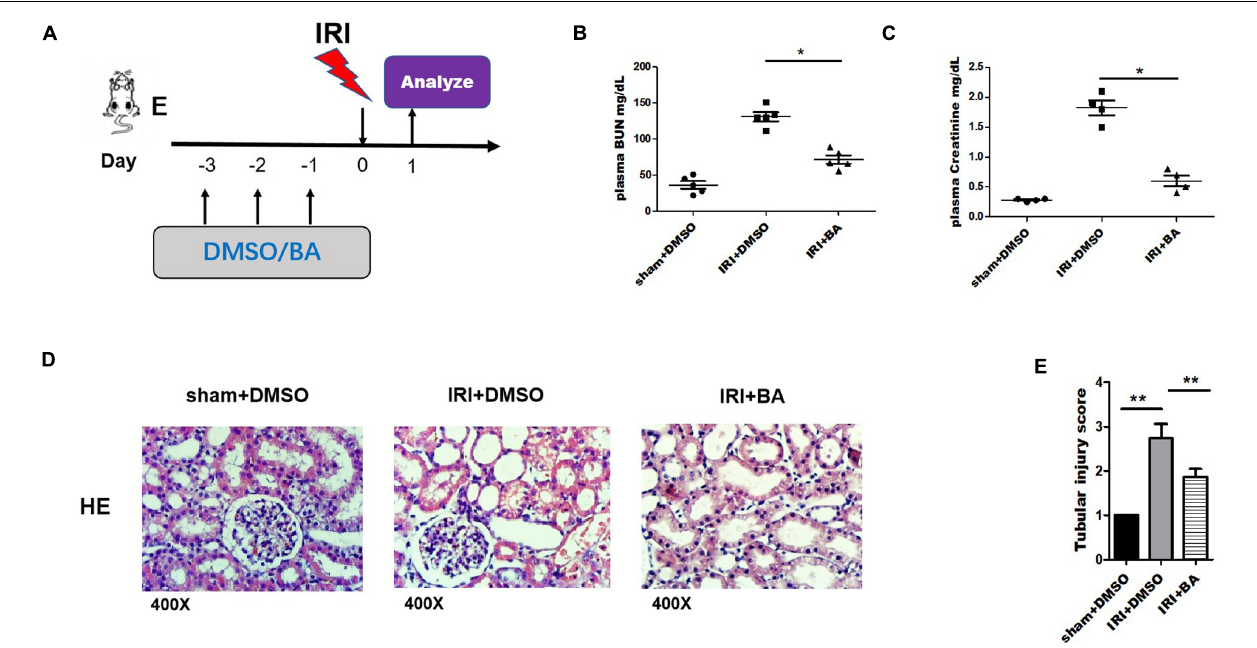
FIGURE 1 | BA treatment ameliorated renal IRI. (A) Mice were orally administered BA and DMSO 3 days before surgery. (B,C) BUN and Cr of mice on the first day after surgery were tested. (D) HE staining of kidneys in the BA treatment group showed alleviate renal tubular damage, renal tubular epithelial cells atrophy, degeneration, necrosis, and extensive lesion range than control group. (E) BA treatment significantly reduced the tubular injury Paller score in IRI mice. Sample size = 3 in each group. Data were presented as mean ± standard deviation. N.S. P > 0.05, * P < 0.05, ** P <